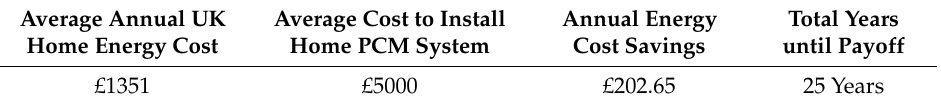
Table 2. Financial Viability of PCM Systems